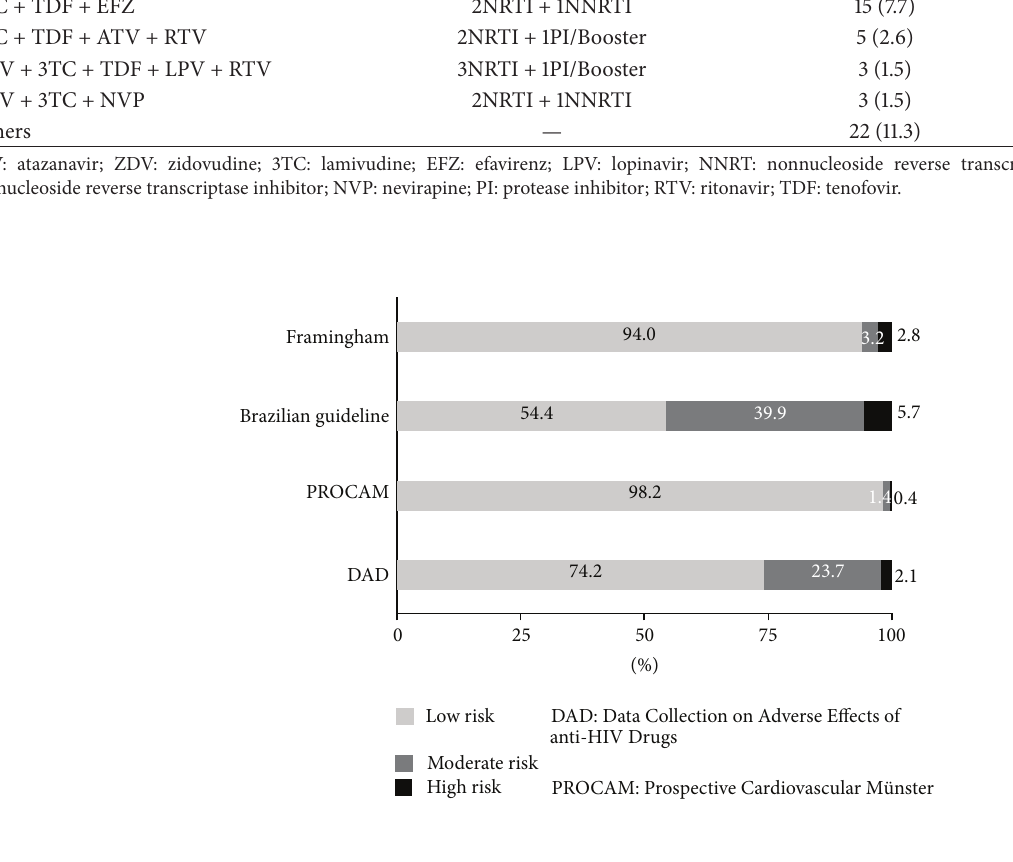
Figure 2: Prevalence of estimated CVD risk according to Framingham, Framingham with aggravating factors (Brazilian Guideline for Dyslipidemia and Atherosclerosis Prevention), PROCAM and DAD risk equations for 283 HIV-infected